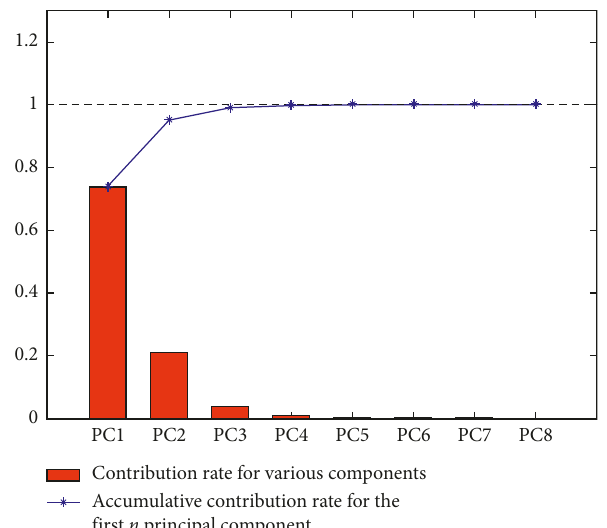
Figure 2: The contribution rate and the cumulative contribution rate of each principal component.